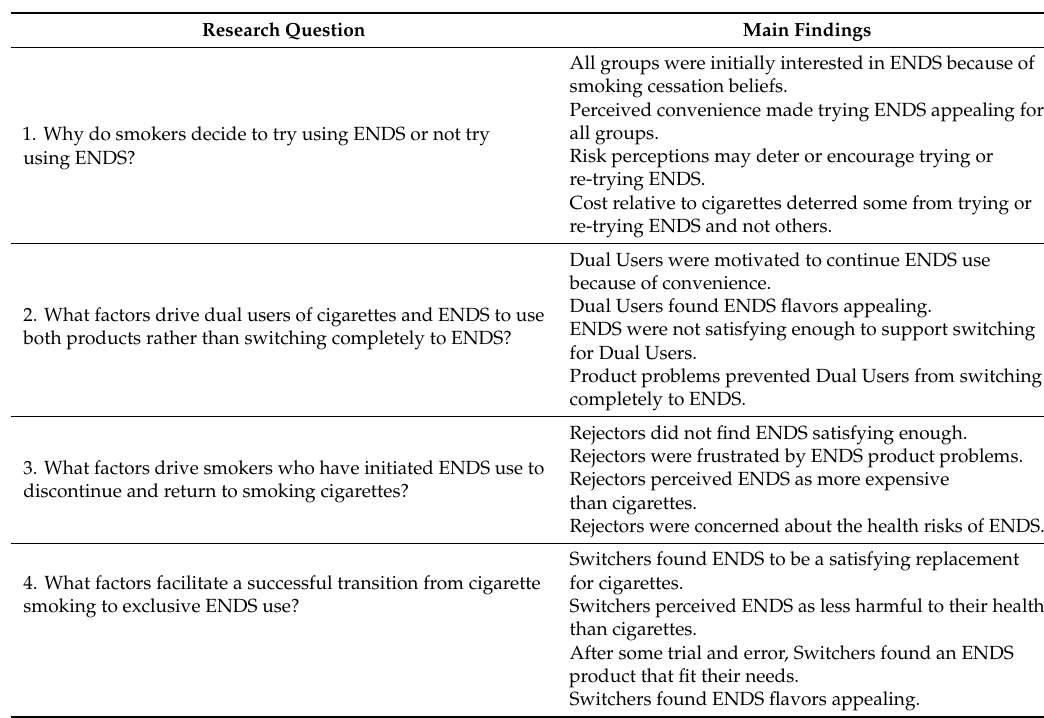
Table 4. Summarization of main